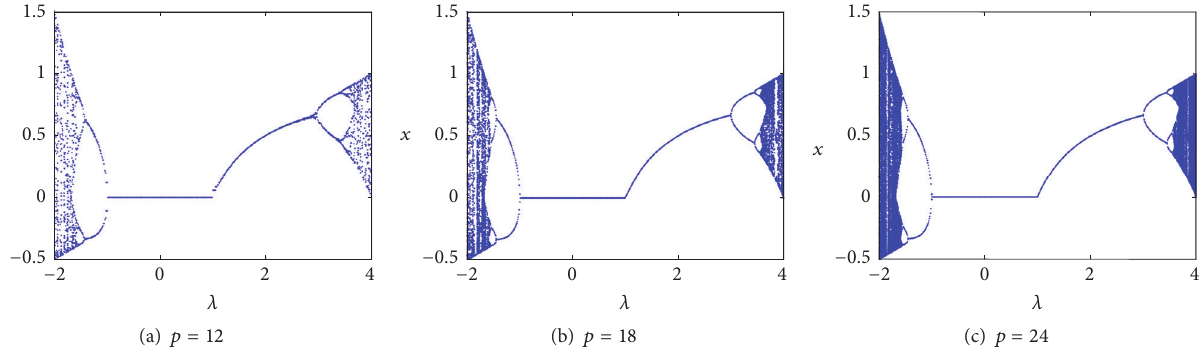
Figure 6: Bifurcation diagram of 𝑓 6 (𝑥) versus the control parameter 𝜆 for different values of bus size starting at 𝑥 0 = 0.5